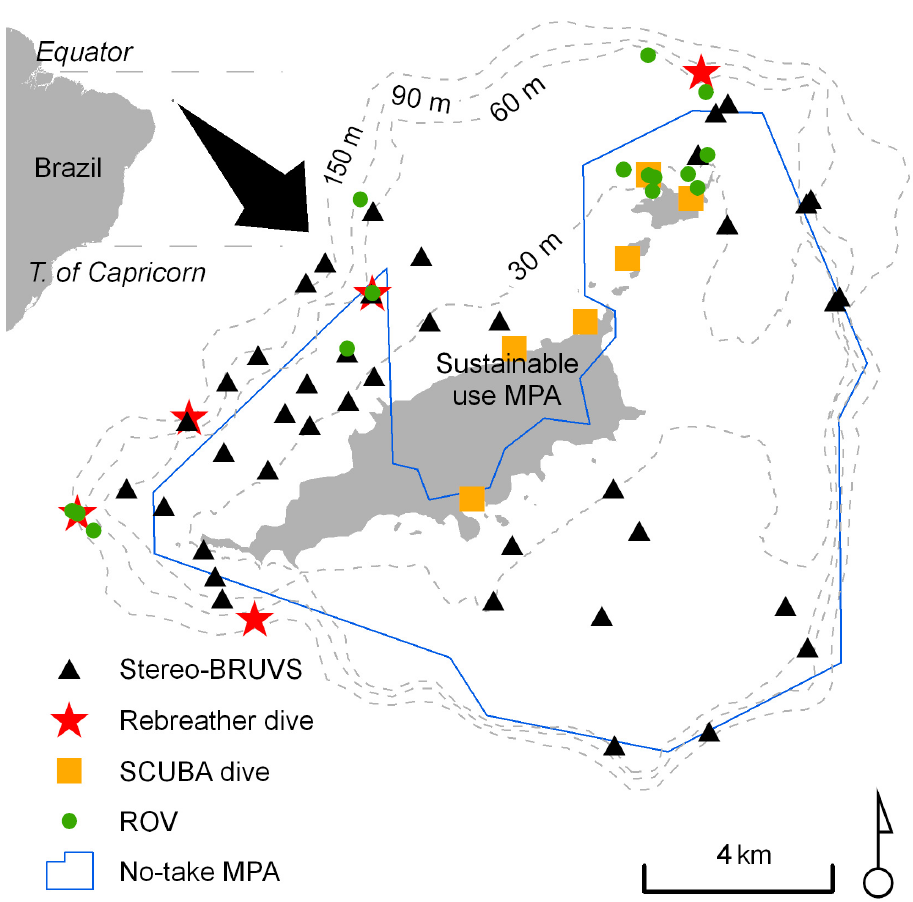
FIGURE 1 | Location of the Fernando de Noronha Archipelago, Brazil (South-western Atlantic). Blue line indicates the area of the Marine National Park of Fernando de Noronha (no-take MPA). Dashed lines indicate the 30, 60, 90 and 150 m isobaths. Black triangles, red stars, golden squares and green dots indicate the position of stereo-BRUVS deployments, rebreather dives, SCUBA dives and ROV footages,